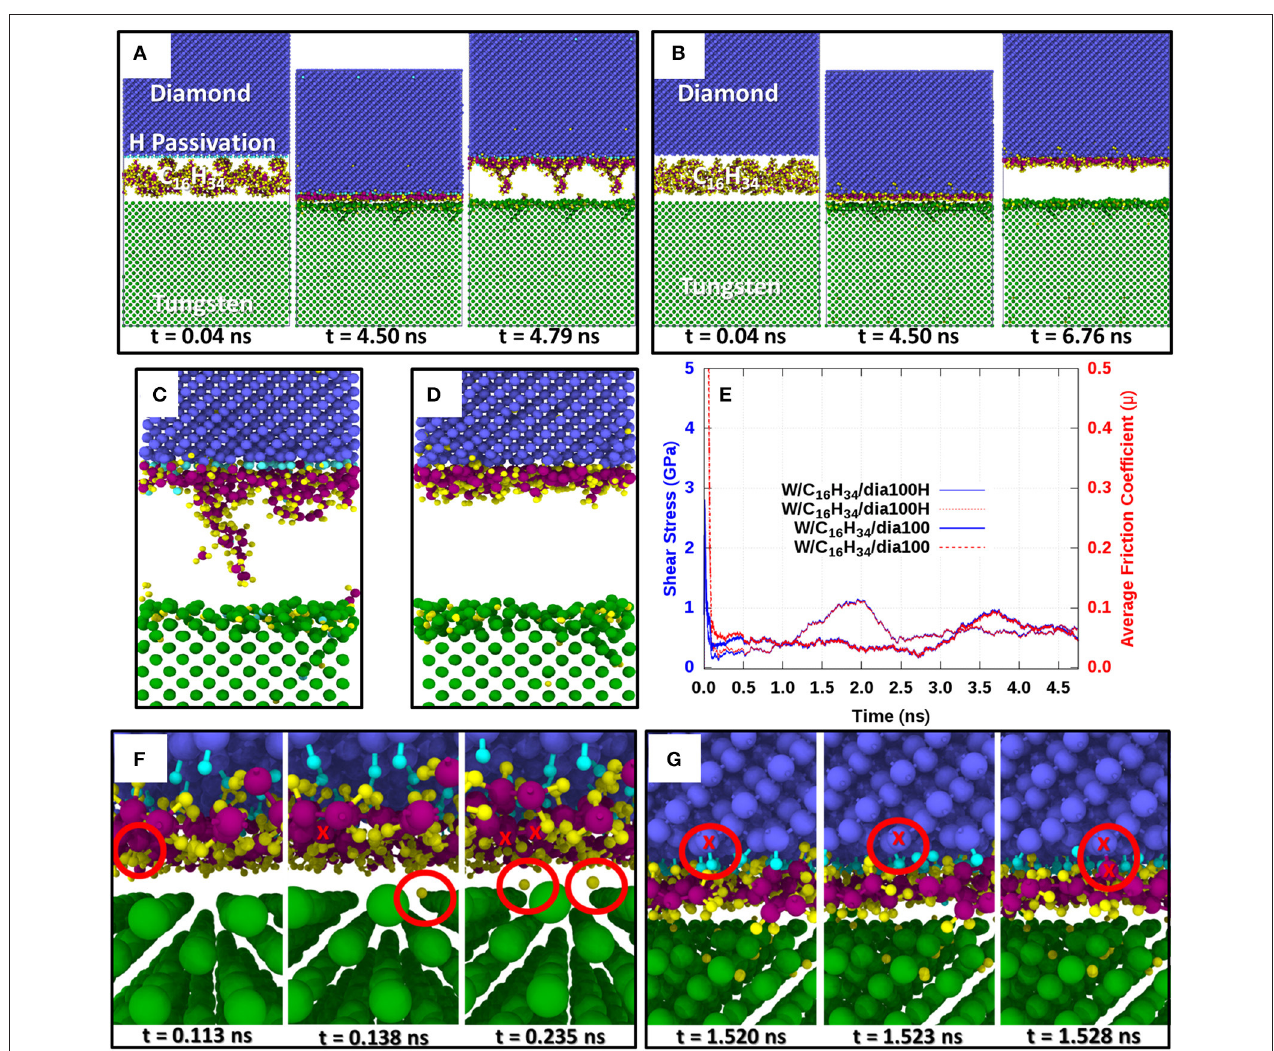
FIGURE 1 | Classical molecular dynamics simulations of hexadecane-lubricated tungsten/diamond tribocouples. Diamond carbon atoms are colored in blue, W atoms in green, H atoms in yellow, hexadecane C atoms in purple, and H atoms terminating the diamond surface in cyan. The lower surface is always a bare tungsten (100) surface. (A) Evolution of the lubricated tribocouple with H termination of the reconstructed diamond (100) surface W(100)/C 16 H 34 /dia(100)H. (B) Evolution of the lubricated tribocouple without H termination of the reconstructed diamond (100) surface W(100)/C 16 H 34 /dia(100). (C,D) Close-up views of the contact interface after retraction for the cases in (A) and (B) , respectively. The plot in (E) shows the evolution of shear stress (solid blue lines) and coefficient of friction (dotted red lines) for W(100)/C 16 H 34 /dia(100)H and W(100)/C 16 H 34 /dia(100). Close-up views of the initial chemical reactions observed for W(100)/C 16 H 34 /dia(100)H are depicted in (F) and (G) . (F) Initial radicalization of C 16 H 34 hydrocarbons after dissociation of H atoms while in sliding contact under high pressure ( ∼ 10 GPa). (G) First bonding of radicalized hydrocarbons on the diamond surface after the dehydrogenation of the initially fully H-passivated diamond (100)